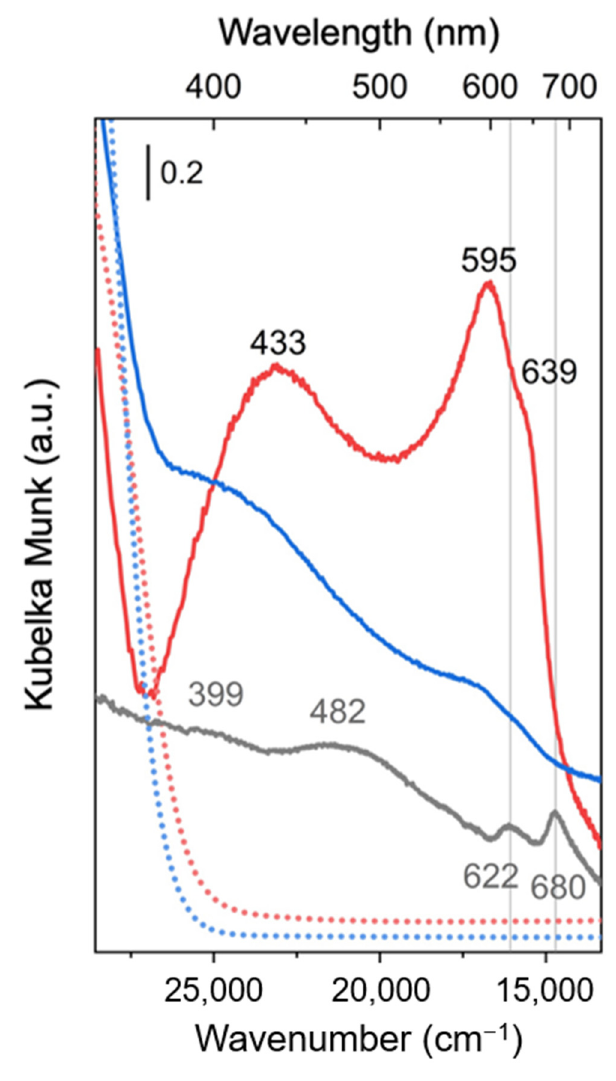
Figure 5. UV-Vis spectra of: MoS 2 /TiO 2 bipy (red line), MoS 2 /TiO 2 n-sh (blue line), TiO 2 bipy (dotted light red line), TiO 2 n-sh (dotted light blue line), and MoS 2 (grey line). For better clarity, the intensities of bulk MoS 2 and of MoS 2 /TiO 2 n-sh spectra are multiplied by a factor of 3 and 2, respectively. The vertical grey dashed lines in the bulk MoS 2 spectrum indicate the position of MoS 2 A and B excitonic transitions. All the spectra are recorded in the diffuse reflectance mode and converted to equivalent absorption Kubelka–Munk units.